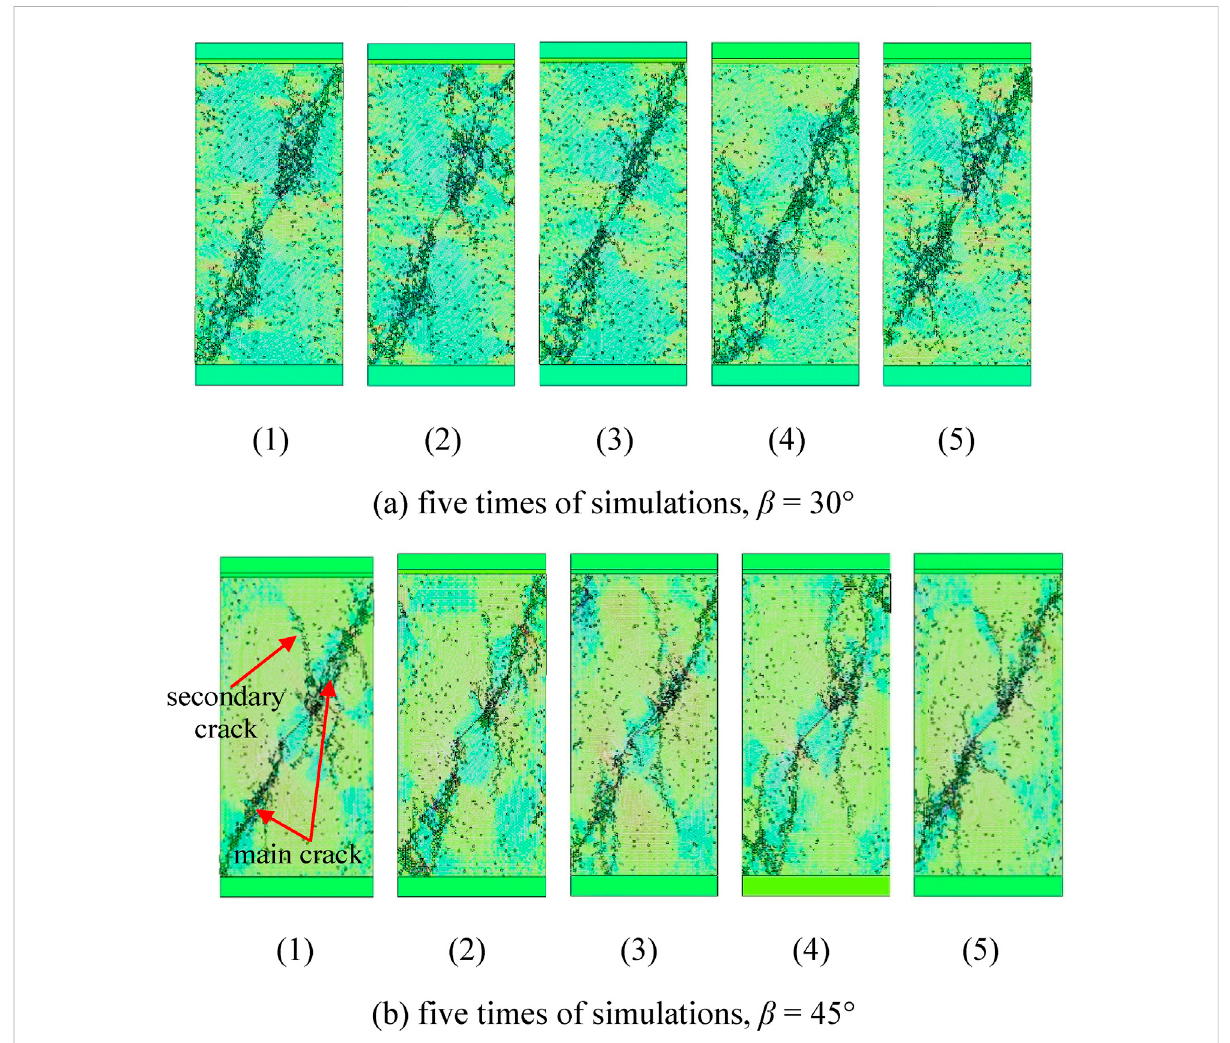
FIGURE 8 Fracturing failure patterns of the center-notched rectangular specimen with different β under the same heterogeneity degree ( m =